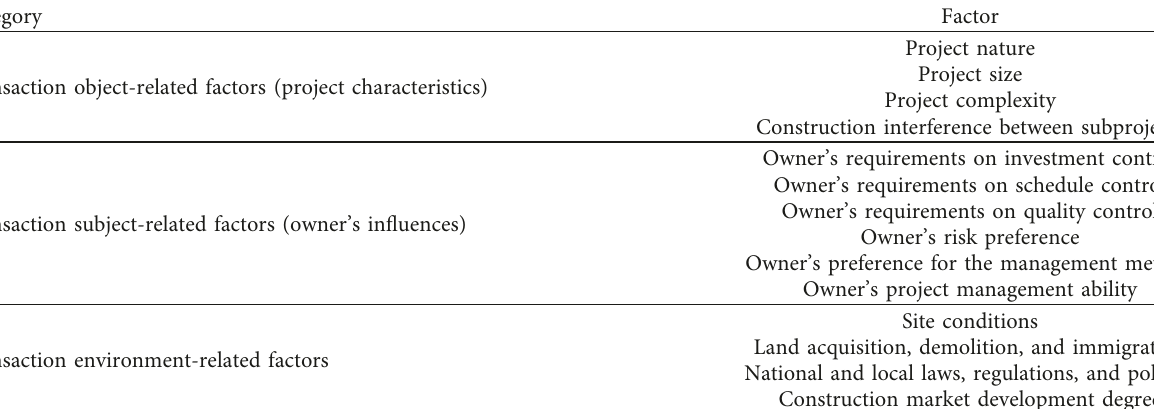
Table 3: Factors for PDCS selection/design (China